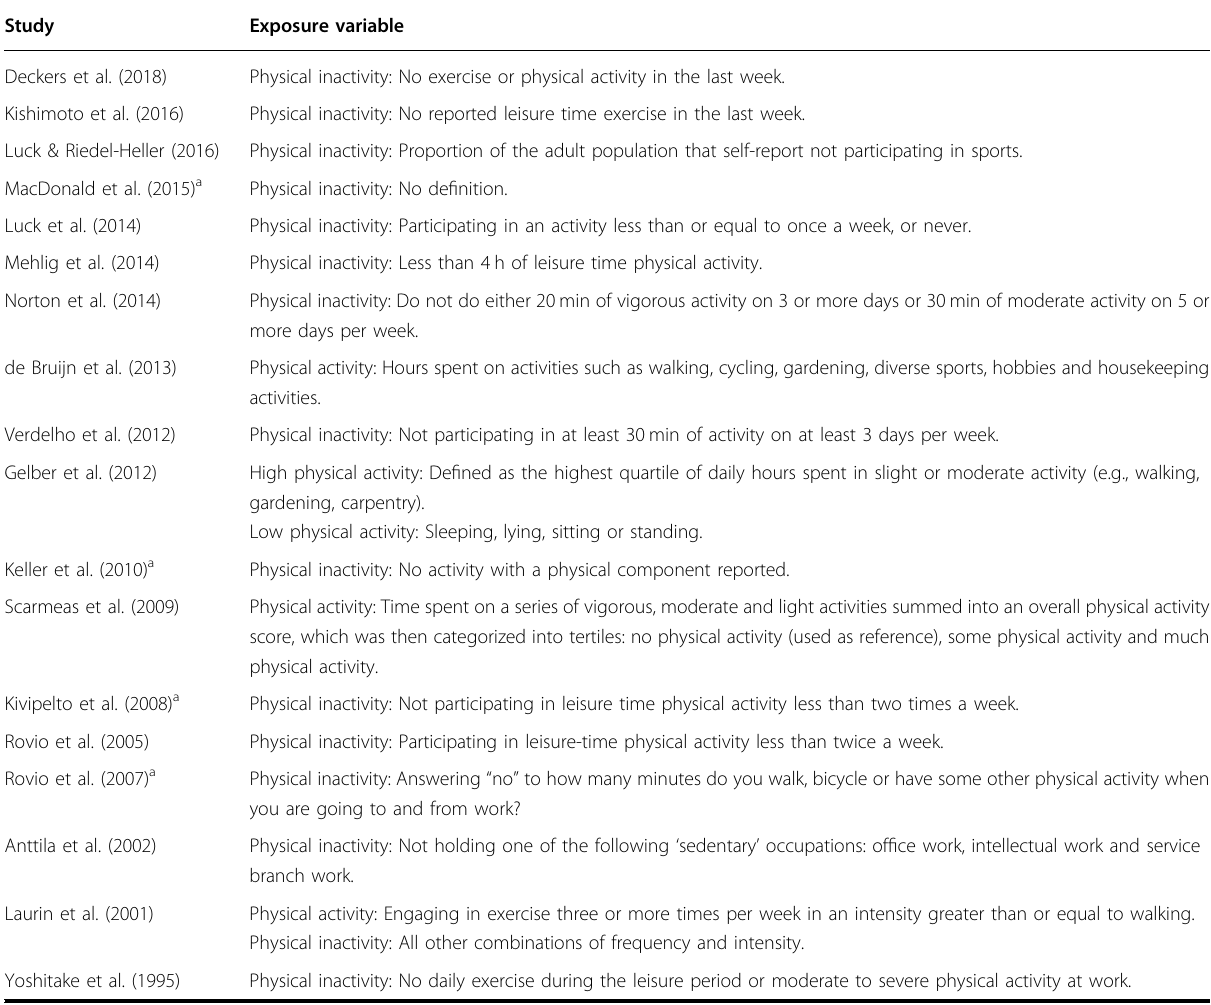
Table 1 Description of exposure variables used within each study of Yan et al. ’ s 1 meta-analysis. Study Exposure